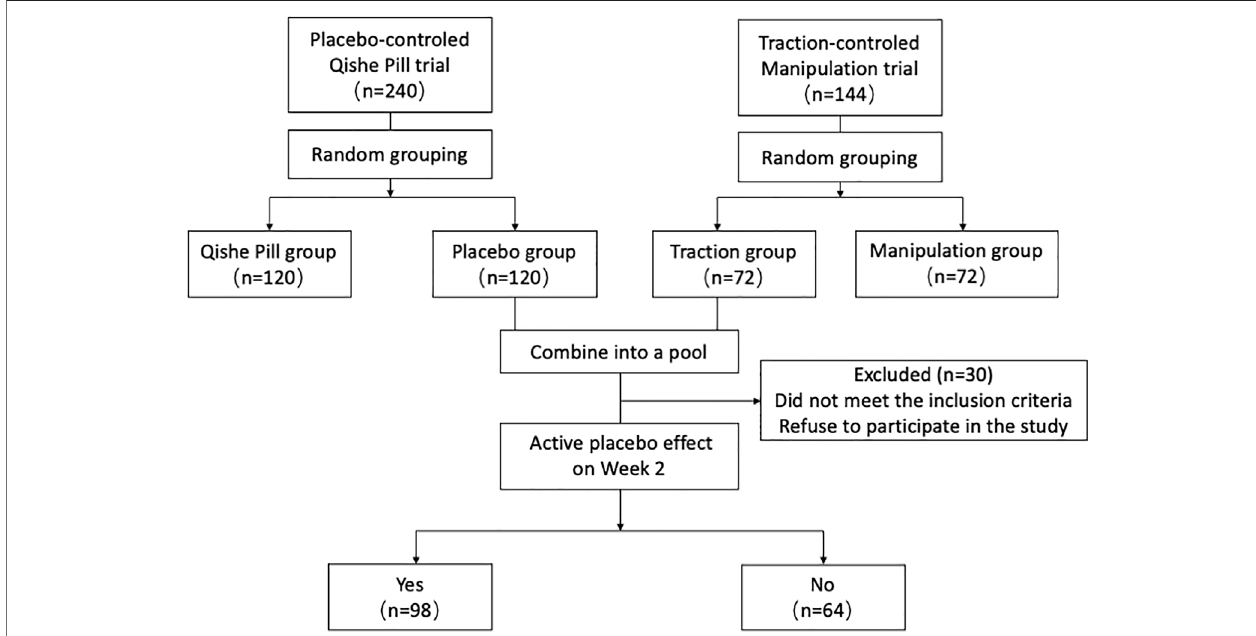
FIGURE 1 | Participant fl ow and pooled analysis procedure.